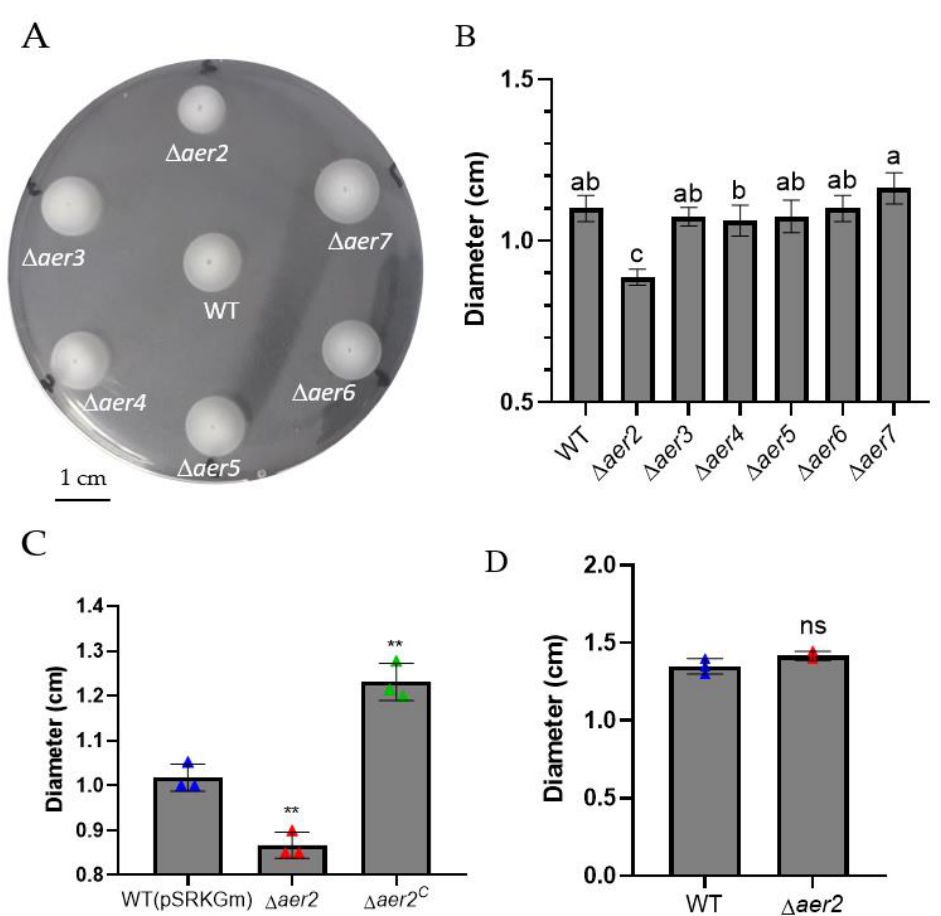
Figure 2. Swarming motility assay. A swarming motility assay was performed using V. cholerae C6706 wild-type (WT), aer mutants, and the aer2 complementary strain ( ∆ aer2 c ) on succinate soft agar plate ( A ), and the average swarm circle diameters were measured ( B ). Different letters in a single column indicate a significant difference between treatments (One-way ANOVA; p < 0.05). ( C ) Swarm ring diameter of wild-type, ∆ aer2 mutant, and aer2 complementary strain. Plates were incubated at 30 °C for 24 h. ∆ aer2 mutant exhibited limited swarming motility, and ∆ aer2 c had swarming motility superior to that of the wild type. ( D ) Swarming motility assay in anaerobic conditions. KNO 3 was added to the medium as the alternative electron acceptor. Plates were incubated in an anaerobic chamber at 30°C for 4 d before the swarm ring diameter was measured. **, p < 0.01; ns, no significance (Student t -test).